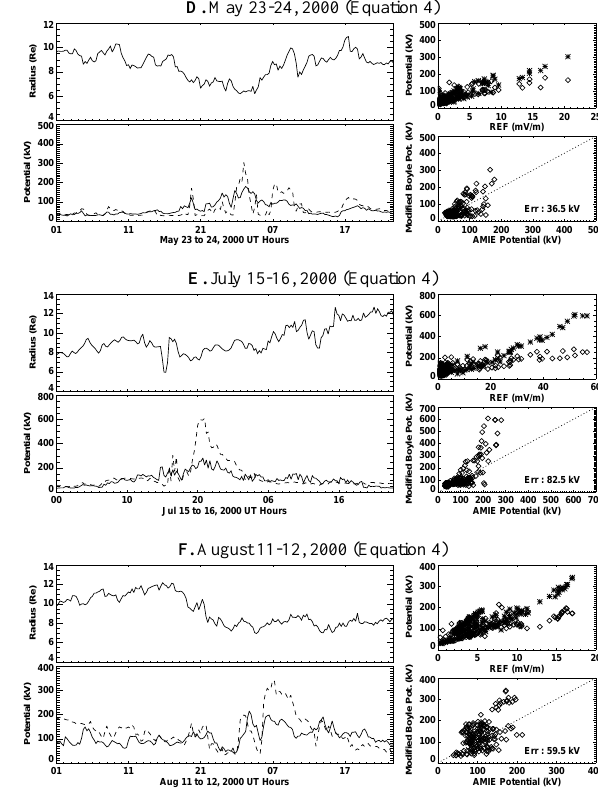
Fig. 5. The same three events in Fig. 1, plotted in the same way, Fig.5. ThesamethreeeventsinFigure1,plottedinthesameway, exceptEquation4wasusedrather except Eq. (4) was used rather than estimating the CPCP with Boyle than estimating the CPCP with Boyle et al. (1997). The top plot is the radius of the magnetosphere, et al. (1997). The top plot is the radius of the magnetosphere, as as estimated by Equation 5. estimated by Eq. (5).